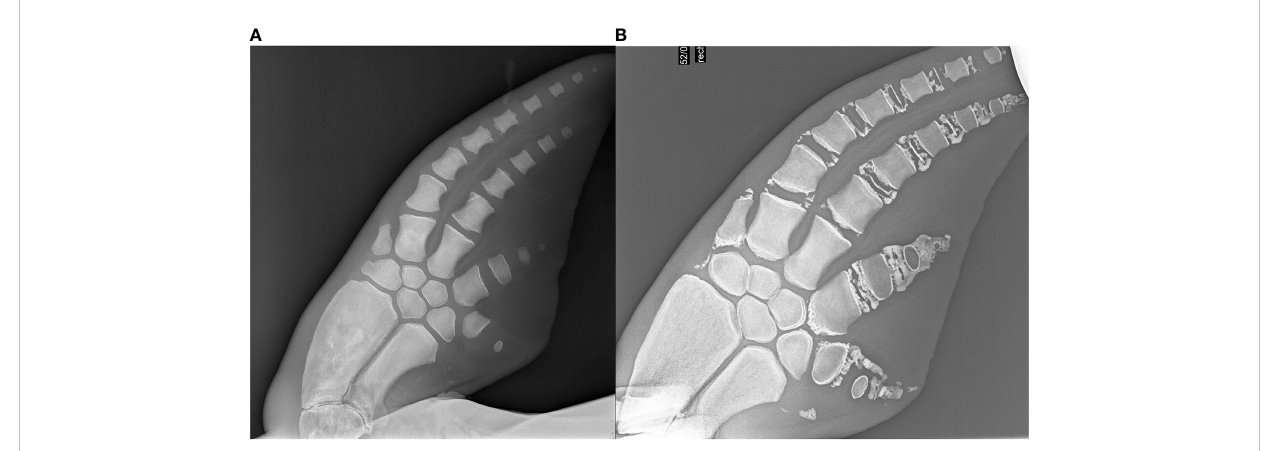
FIGURE 10 Geriatric radiographs in two 58year old dolphins. (A) Is the radiograph of a 57 year old female dolphin. (B) is a 58 year old male dolphin. (A) was underestimated in age as there are minimal degenerative changes. These radiographs demonstrate both the variability and subjectivity of this technique at the older age range. Both of these dolphins were in managed